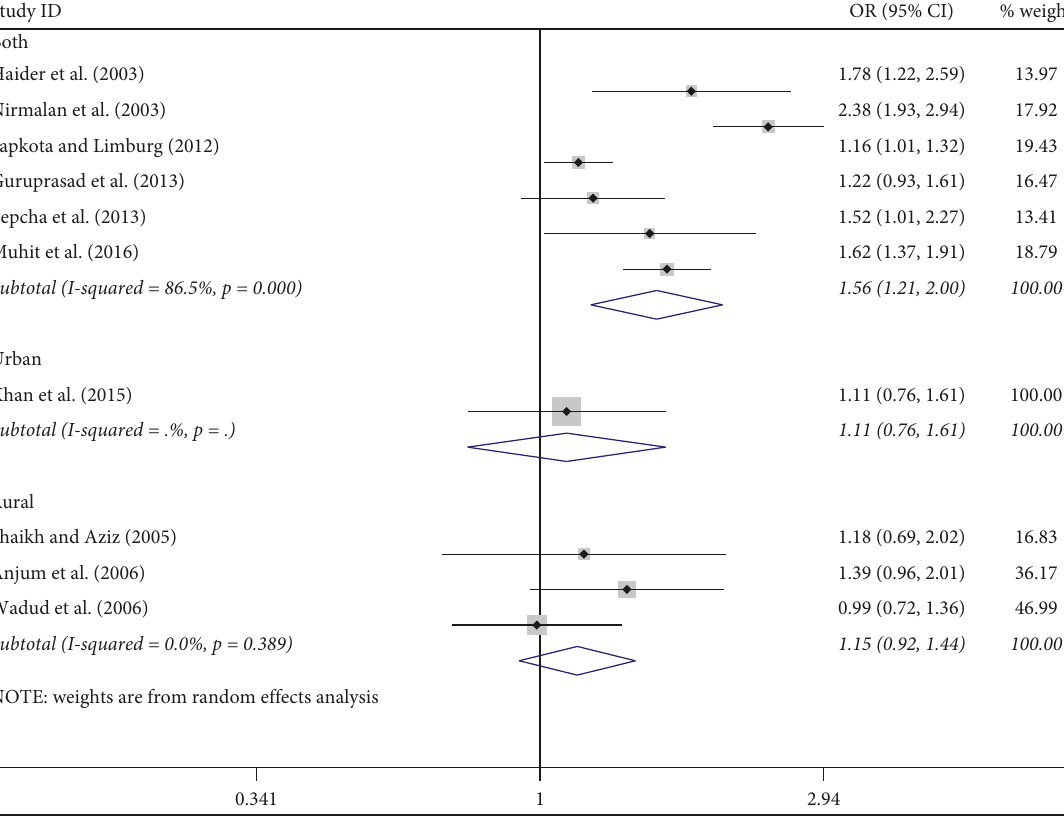
Figure 11: Subgroup analysis of CSC by location on an eye basis at visual < 3/60 level. CSC � cataract surgical coverage; OR � odds ratio; CI � confidence interval.